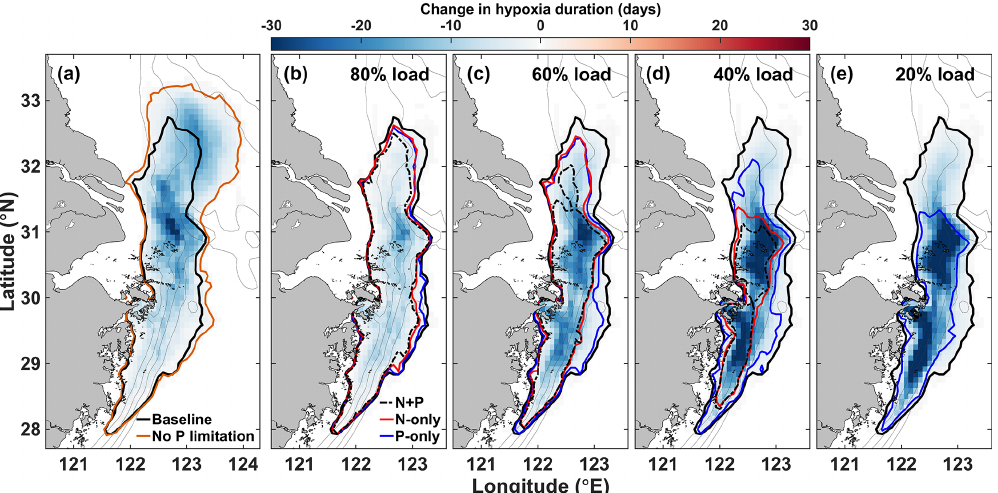
Figure 8. Change in hypoxia duration due to (a) P limitation (baseline – NoPlim) and to (b–e) nutrient reduction in the Changjiang. The black contour indicates the area where annual hypoxia duration is at least 1d in the baseline simulation (2008–2013 mean). The orange contour (a) and the dashed red and blue contours (b–e) are the equivalents in the NoPlim and nutrient load simulations,